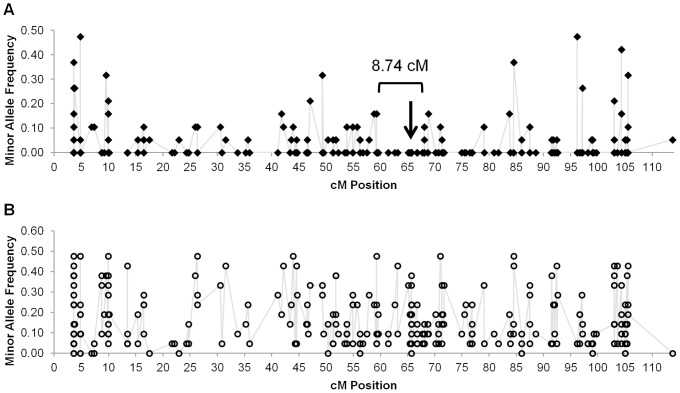
Polymorphism among pungent and non-pungent lines on chromosome P2.Minor allele frequency by cM position across (A) non-pungent and (B) pungent lines. An 8.75 cM region of P2 containing pun11 (↓) is monomorphic among the non-pungent lines.